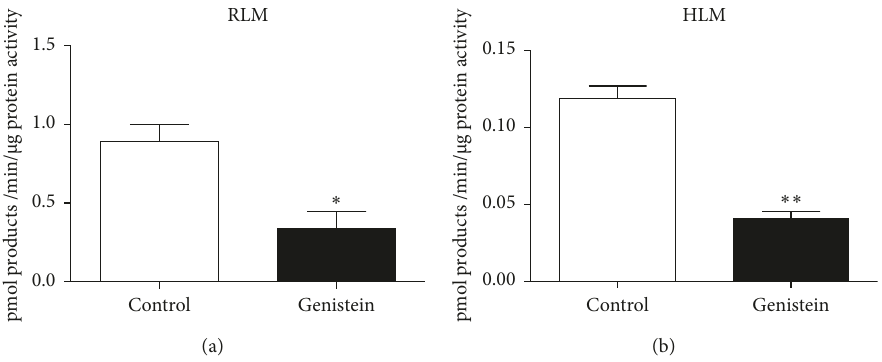
Figure 3: Effects of 100 µ M genistein on converting celecoxib.